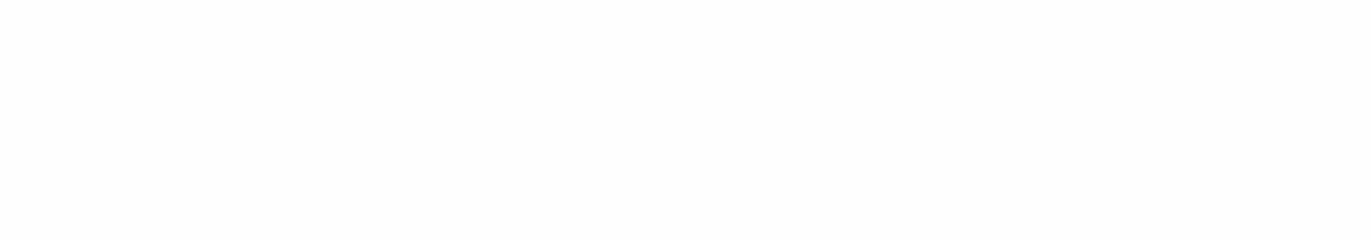
FIGURE TM-3 tokamak. The temporal behavior ofthe image of the glowing plasma. The slit, looking at the plasma, was reflected upon the rotating film. The tine pusses from top left to bottom